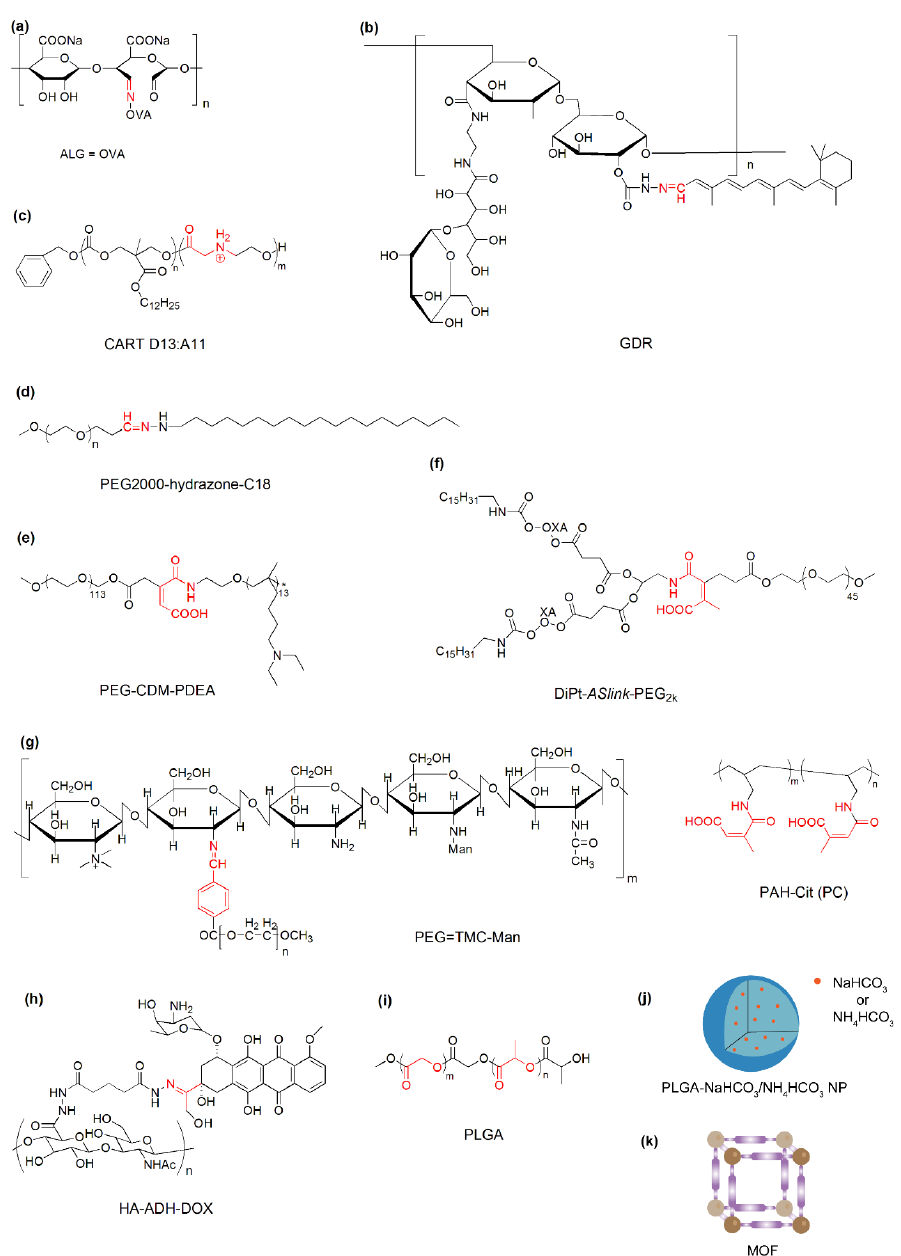
Figure 4. Representative materials with acid-labile bond cleavage or degradation for cancer